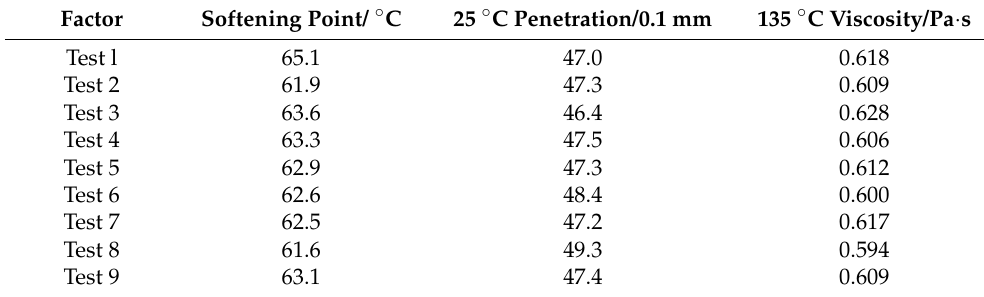
Table 5. Properties of PE-modified asphalt.